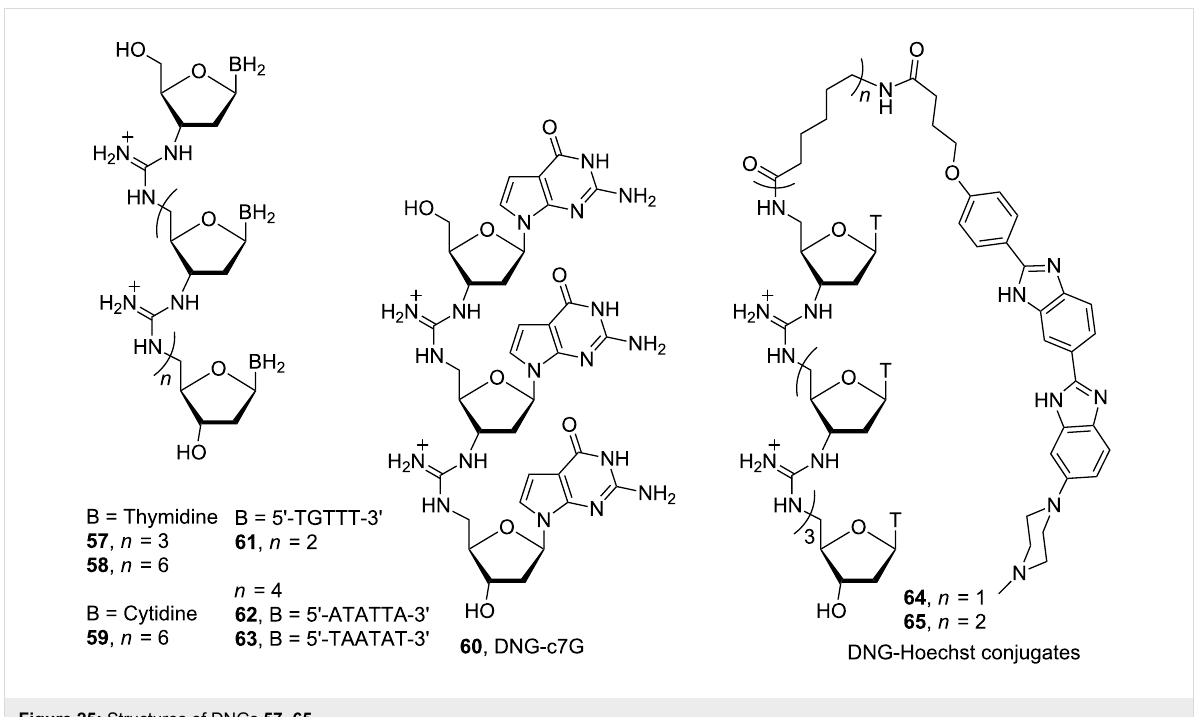
Figure 25: Structures of DNGs 57 – 65 .